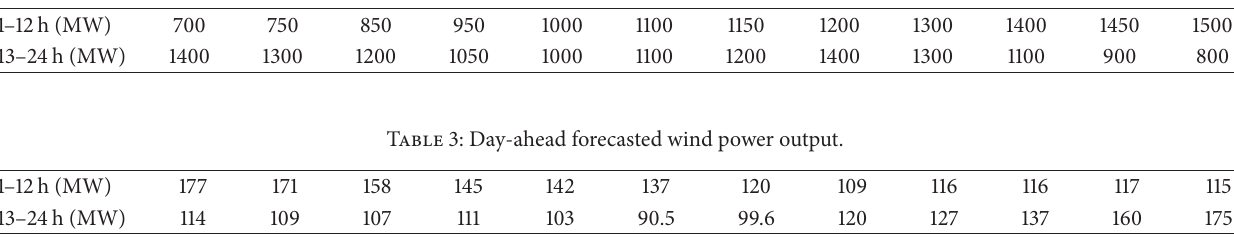
Table 2: Hourly load data.